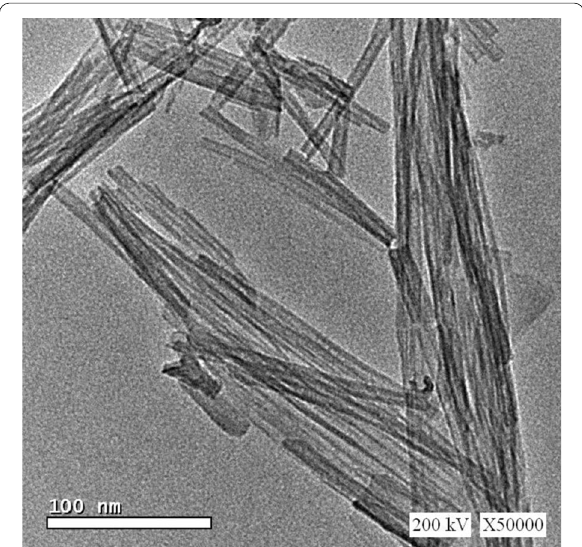
Fig. 3 HRTEM image of the prepared sodium titanate nanotubes